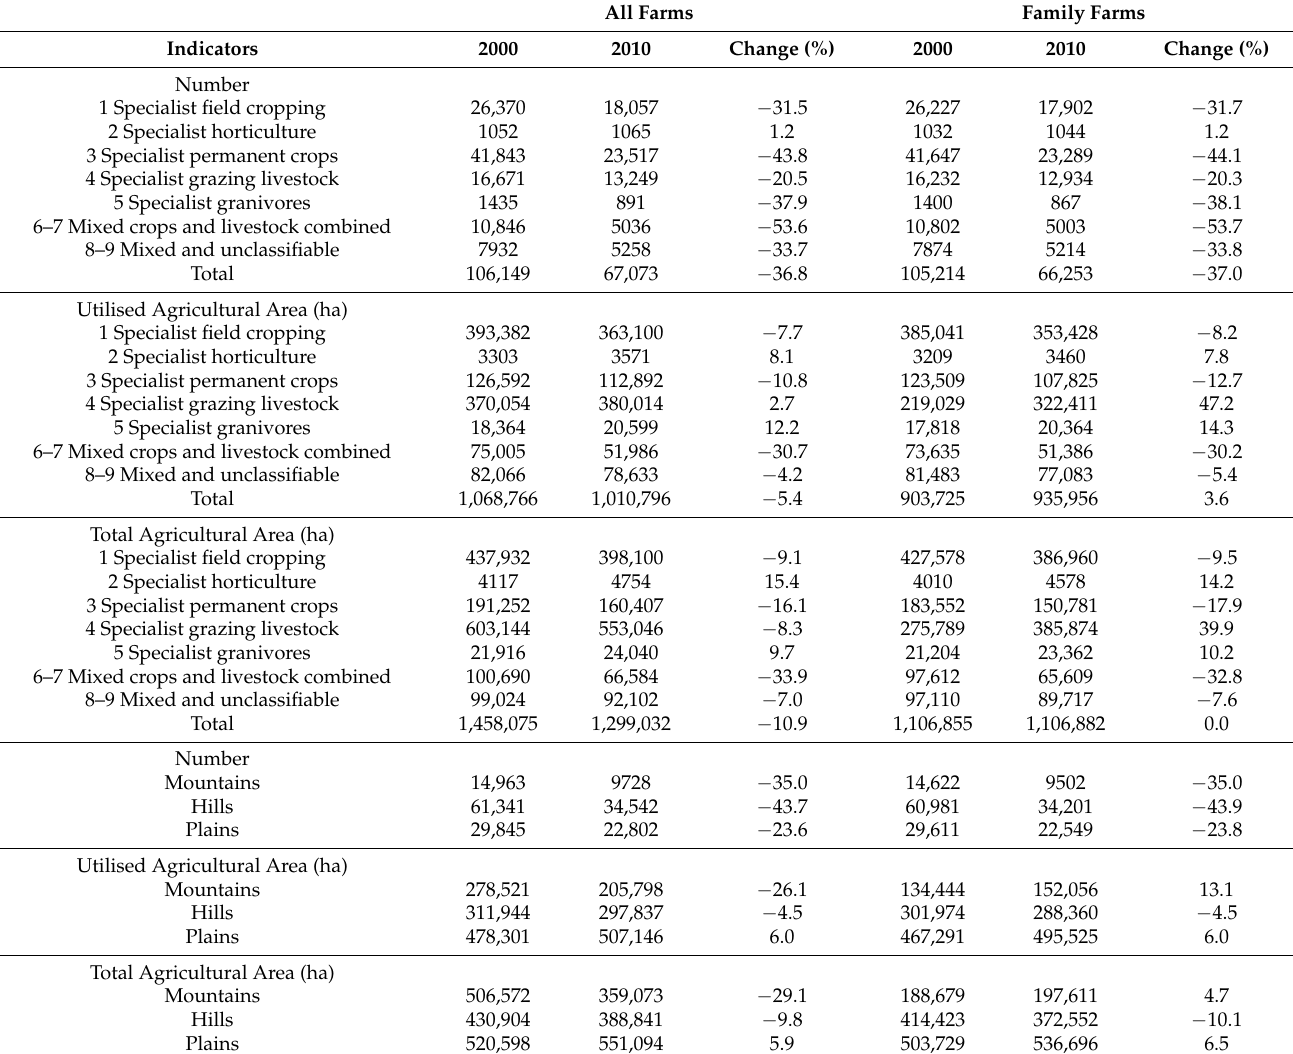
Table 1. Number, Utilised Agricultural Area and Total Agricultural Area by the type of farming and elevation zones. All Farms Family